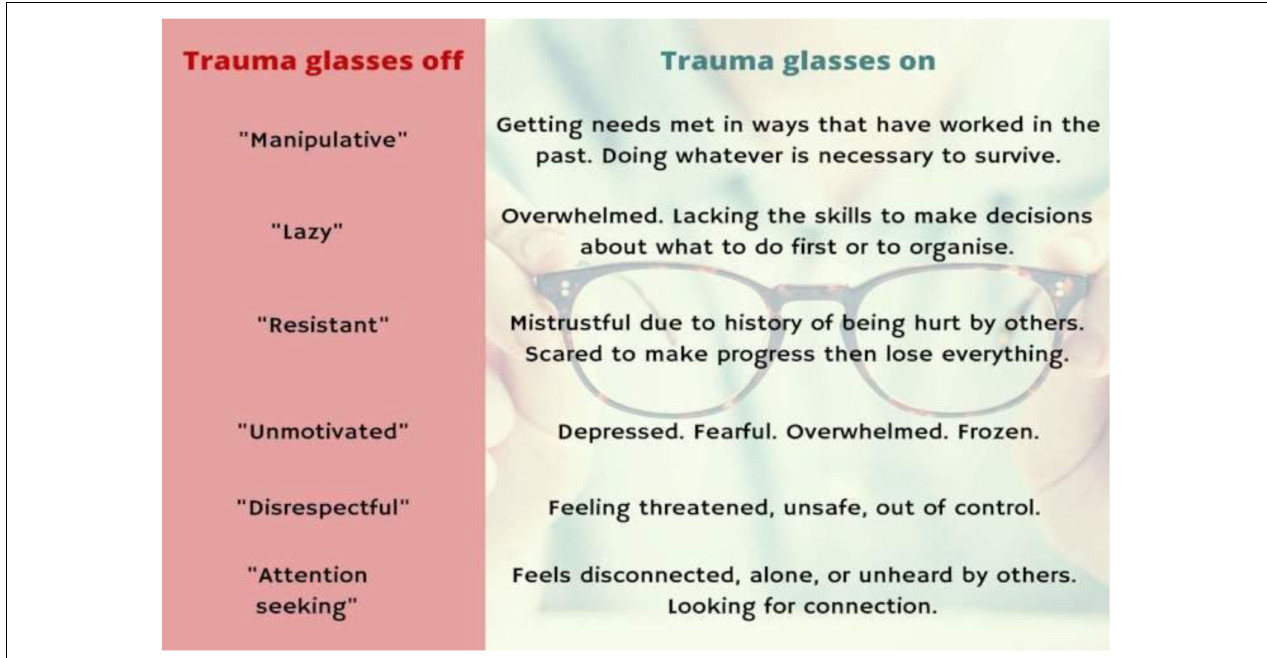
FIGURE 1 | Trauma glasses off and on (Thrive, 2021 Module 1: Promoting attachment and